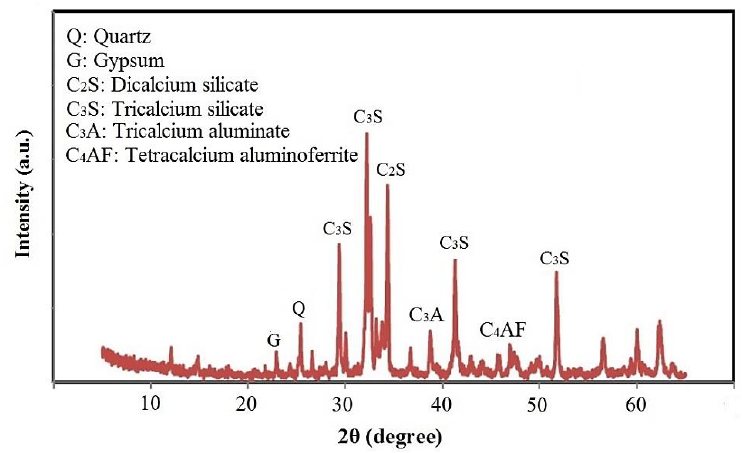
Figure 1. XRD patterns of the OPC.